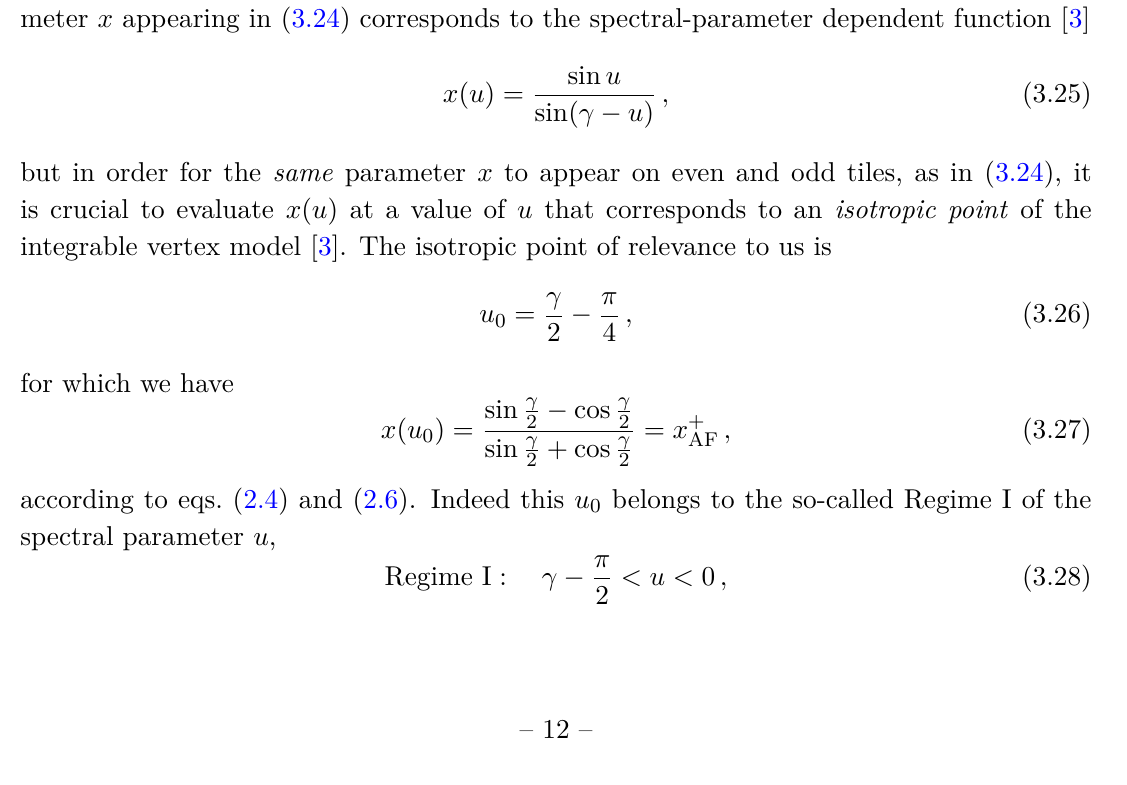
Figure 7 . The lattice from figure 6 but with each edge replaced by two spin- 1 dotted lines. The full lines represent the tiles that surround each